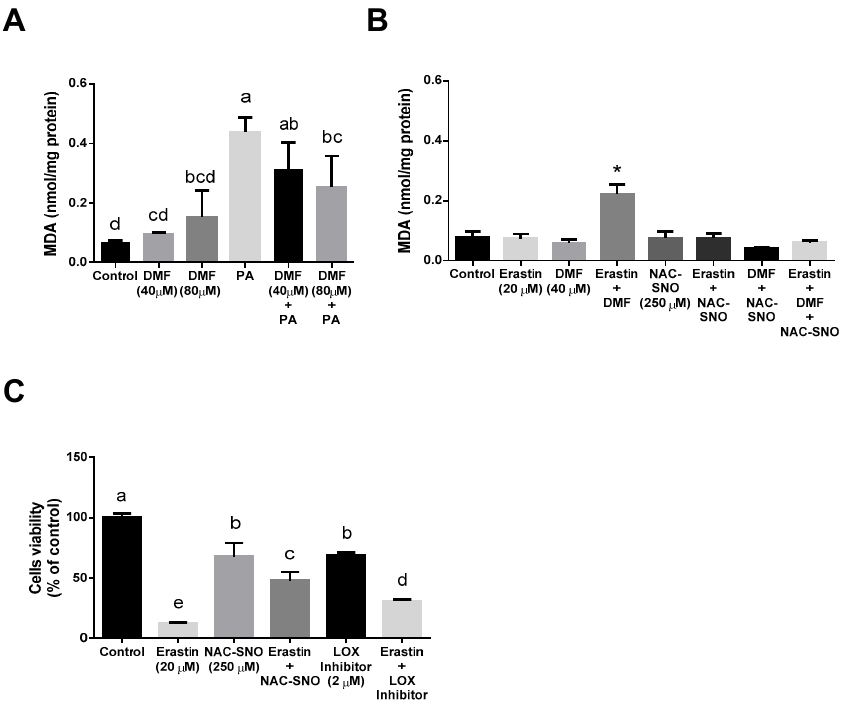
Figure 4. Oxidative stress in lipotoxicity and ferroptosis: MDA levels were measured in ( A ) AML12 treated with 40 or 80 µ M DMF for 6 h before 600 µ M palmitic acid (PA) for a total of 24 h. ( B ) AML12 cells were treated with 20 µ M erastin with or without 40 µ M DMF and 250 µ M NAC-SNO for 6 h. ( C ) Cell viability was measured by MTT assay of AML12 treated with 20 µ M Erastin with or without 250 µ M NAC-SNO and 2 µ M LOX inhibitor (ML351) for 24 h. Means with different letters are statistically different ( p < 0.05). Column marked with * is statistically different from the rest ( p < 0.05).